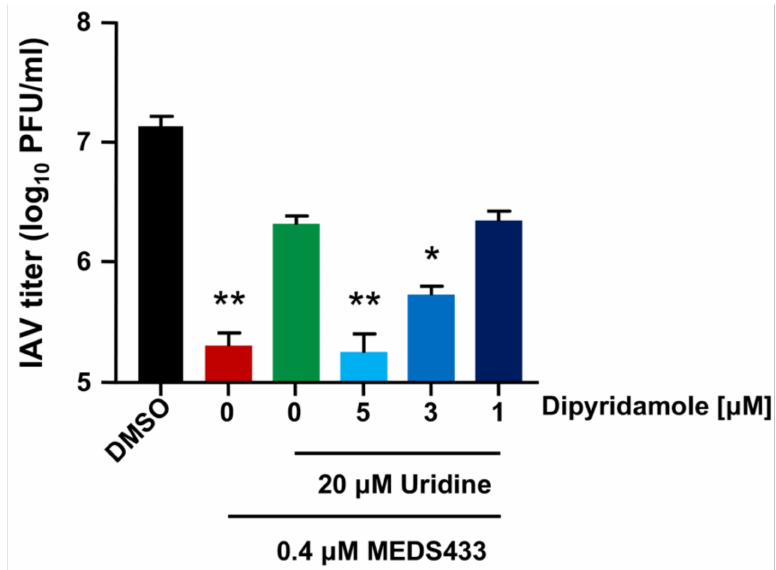
Figure 7. A combination of modulators of pyrimidine metabolism inhibits IAV replication in the presence of exogenous uridine. VRAs were performed in A549 cells treated with MEDS433 alone or in combination with different concentrations of DPY. Where indicated, infected cells were supplemented with 20 µ M uridine. At 48 h p.i., the cell supernatants were harvested and titrated by the plaque assay in MDCK cells. The data shown represent means ± SDs of three independent experiments performed in triplicate, and MEDS433-treated samples were analyzed by an unpaired t -test, corrected at FDR q < 0.05. * ( p < 0.01); ** ( p < 0.001) compared to the calibrator sample (MEDS433 + 20 µ M uridine, green